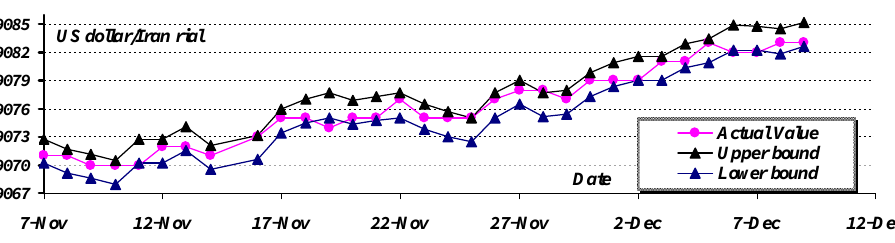
Fig. 8 Upper and lower bounds obtained by proposed model for training data (width =2.6 & α =